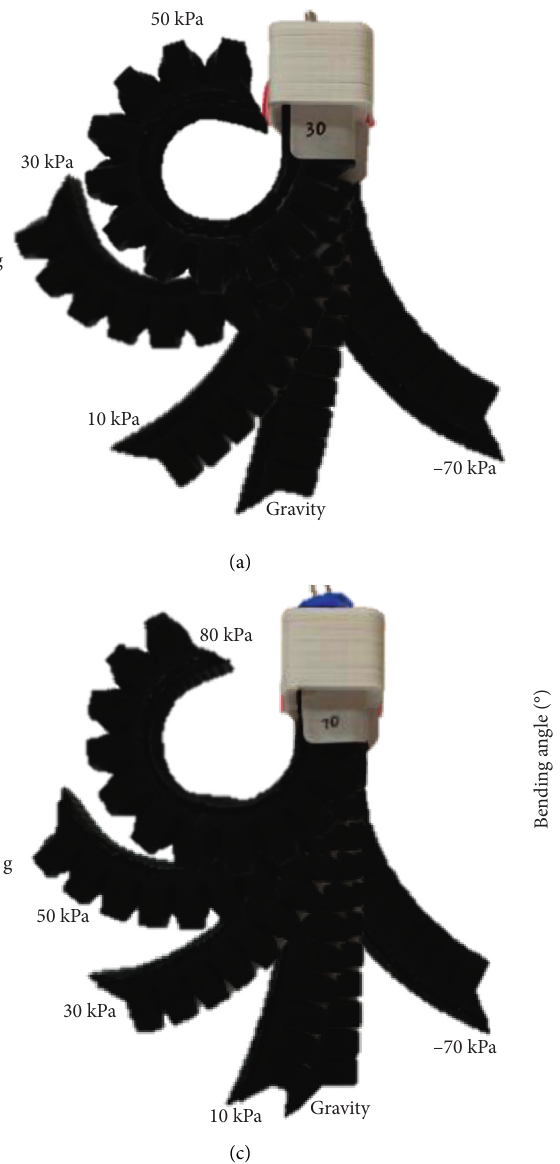
Figure 7: Experimental result. (a) The deformation of the fingers with Shore hardness of 30 under different air pressures. (b) The de- formation with Shore hardness of 50 under different air pressures. (c) The deformation with Shore hardness of 70 under different air pressures. (d) The relationships between the air pressure and bending angle for different soft L indicates the k th optional local path generated by k DWA, H indicates the global path, and c is a weight parameter.